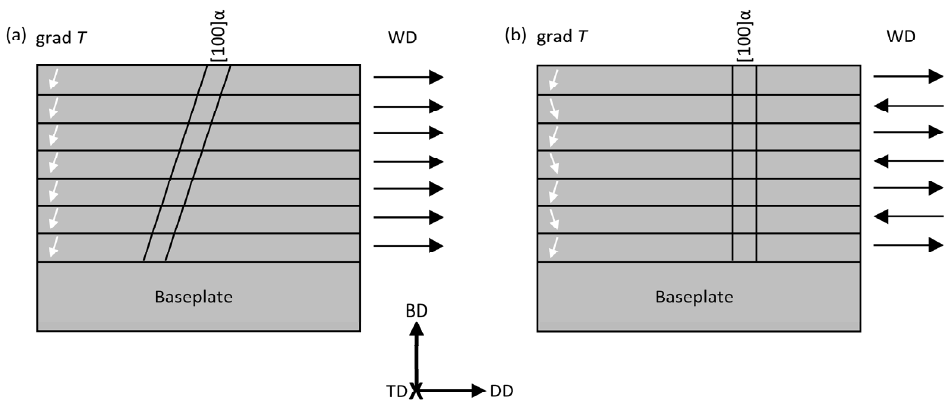
Figure 1. Grain orientation of the α -bcc phase as a function of the temperature gradient grad T (white arrow) and the welding direction WD (black arrow) for ( a ) unidirectional welding and ( b ) bidirectional welding; the structure is defined by the coordinate system containing building direction (BD), deposition direction (DD) and transverse direction (TD), respectively.